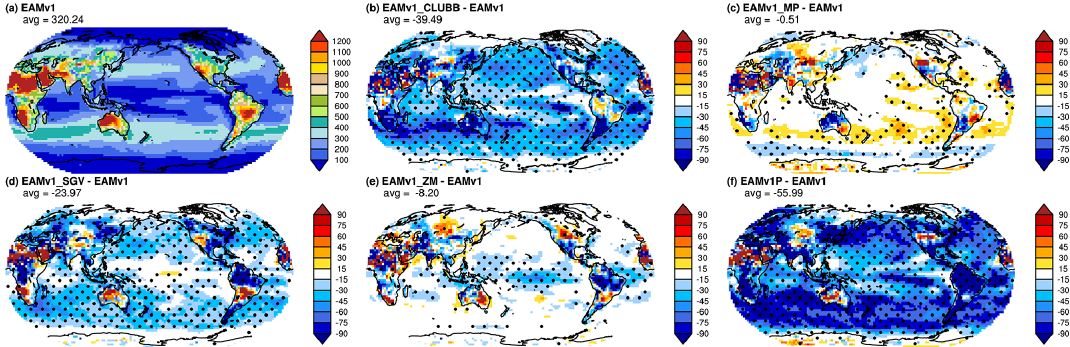
Figure 7. PBL decoupling strength (unit = m) defined as the difference between LCL and the altitude of the cloud base (Jones et al., 2011). The PBL decoupling strength is computed at every cloud physics time step (d t = 5min), averaged over samples where decoupled PBL is